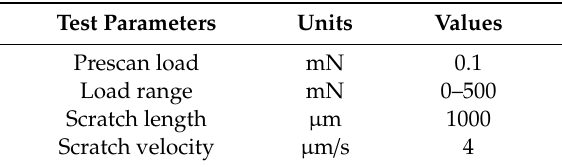
Figure 6. Schematic diagrams of the scratch test: ( a ) prescan stage and ( b ) scratching stage. Table 2. Scratch test parameters.